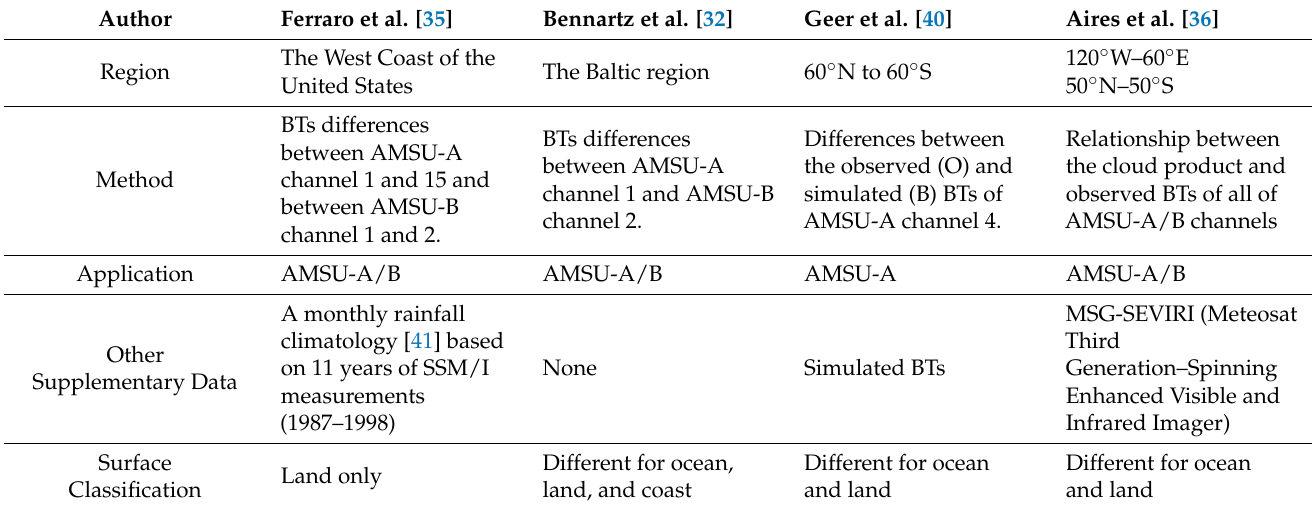
Table 1. Similar cloud detection techniques and main